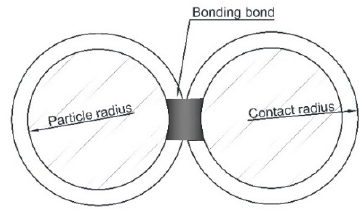
Figure 8. Interparticle bond.